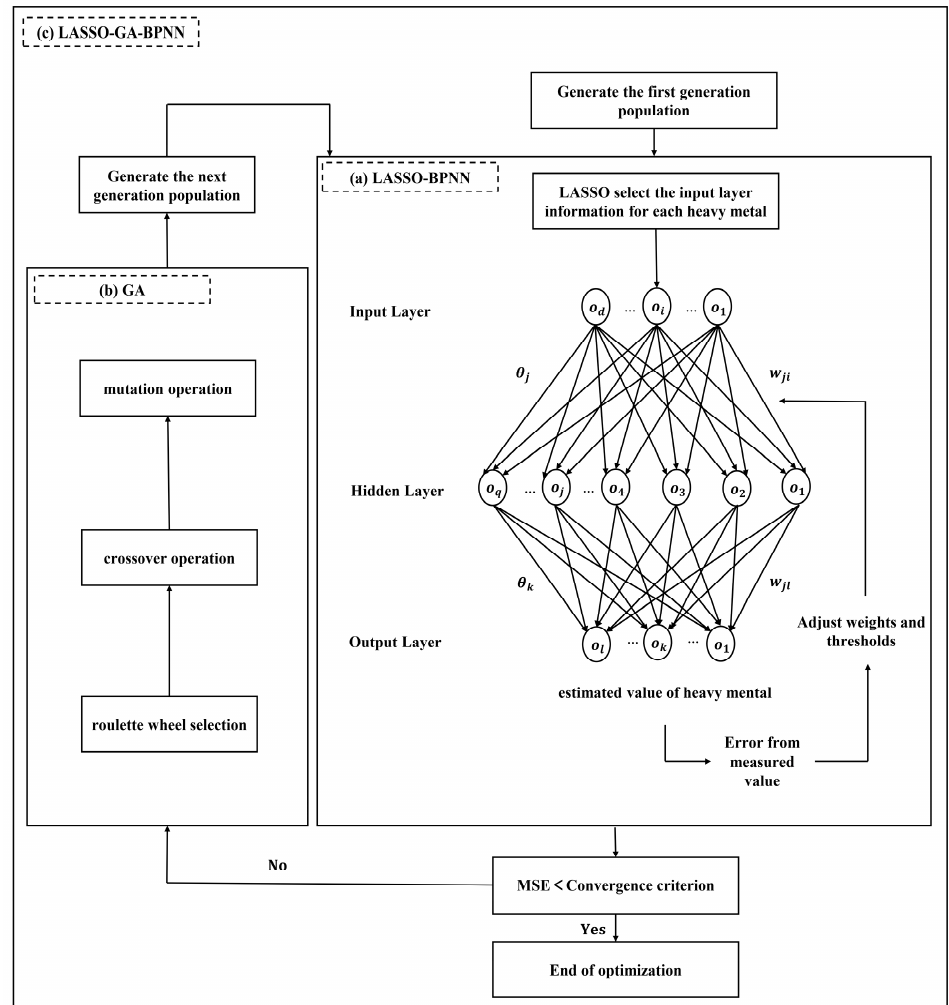
Figure 2. The basic structure of the LASSO-GA-BPNN model (( a – c ) represents the structure of LASSO-BPNN, GA, and LASSO-GA-BPNN, respectively).